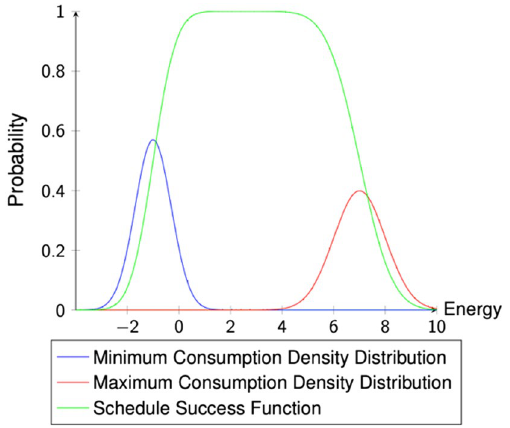
Fig. 2 Example of a slice of a Probabilistic FlexOffer